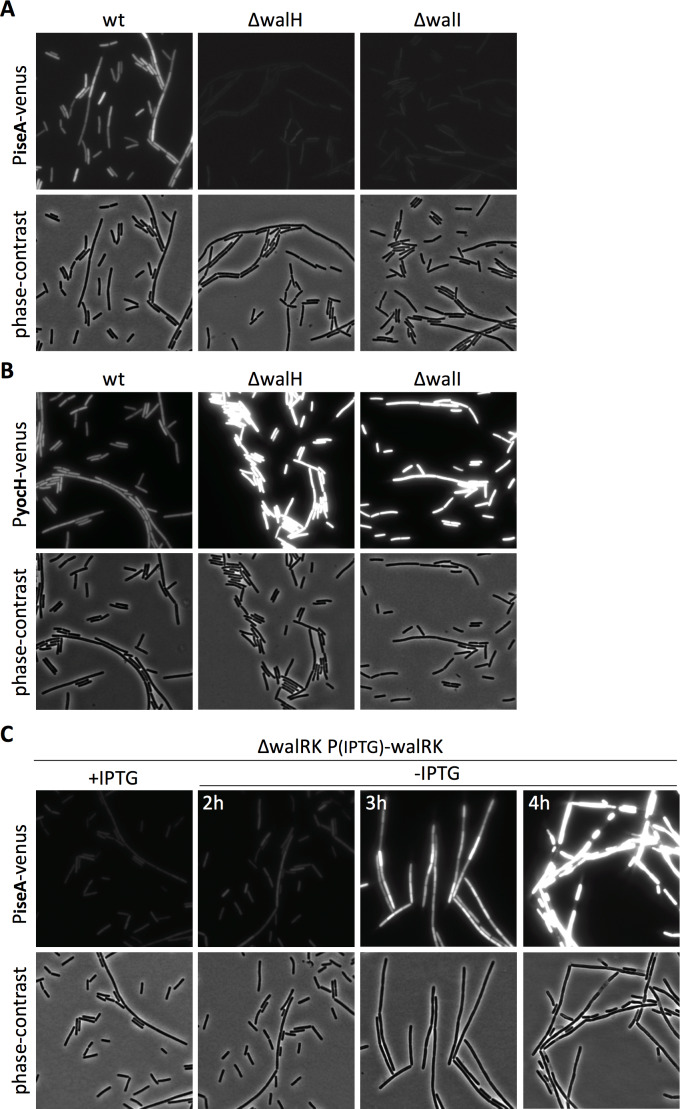
Validation of PiseA-venus and PyocH-venus reporters.(A) Representative fluorescence and phase-contrast images of cells harboring the PiseA-venus reporter in wild-type (wt) and strains lacking WalH (∆walH) or WalI (∆walI) that negatively regulate WalK. Cells were grown in LB medium and imaged at an OD600 of ~0.3. PiseA is strongly repressed in the absence of WalH and WalI due to high WalR ~P levels. (B) Representative fluorescence and phase-contrast images of cells harboring the PyocH-venus reporter in the same strains as in (A). PyocH-venus transcription increases in the absence of WalH and WalI due to high WalR ~P levels. (C) Representative images of cells harboring the PiseA-venus reporter and an IPTG-regulated promoter fused to the walRK genes. Cells were grown in LB medium supplemented with 50 µM IPTG to OD600 of ~0.3, washed with LB to remove inducer, back-diluted to OD600 = 0.05, and imaged at the indicated times. PiseA is strongly depressed upon depletion of WalR.